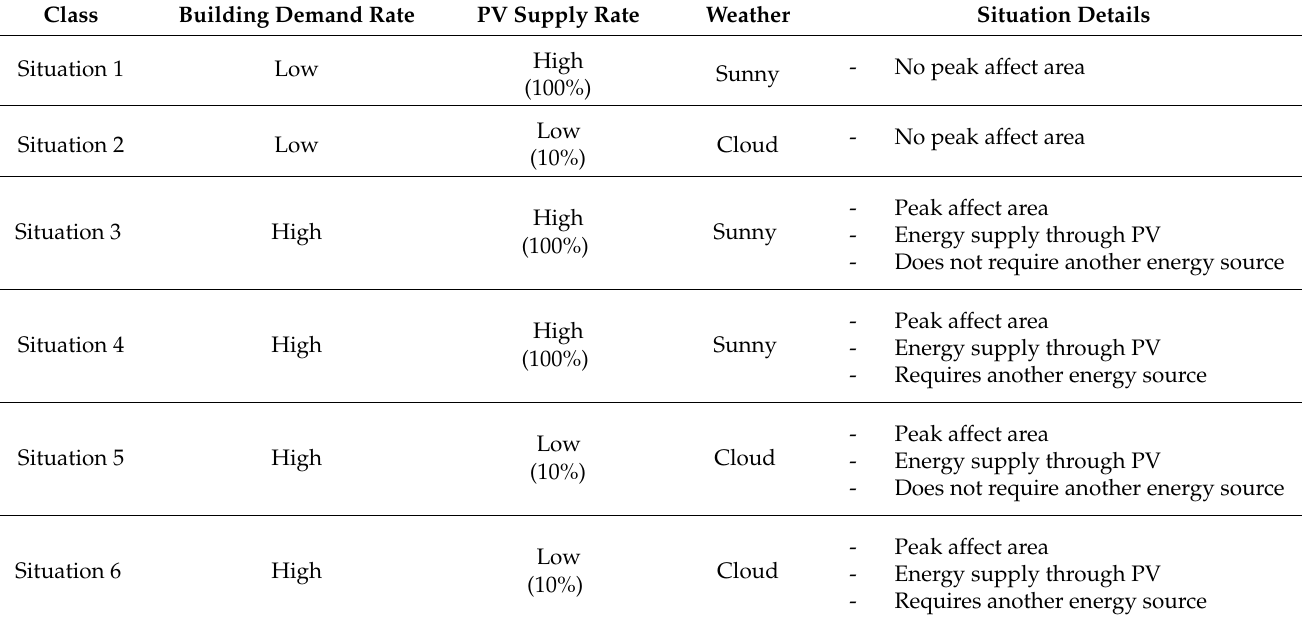
Figure 16. Proposed building situations by day and month. Table 7. Situational Characteristics of The Proposed System Scenario